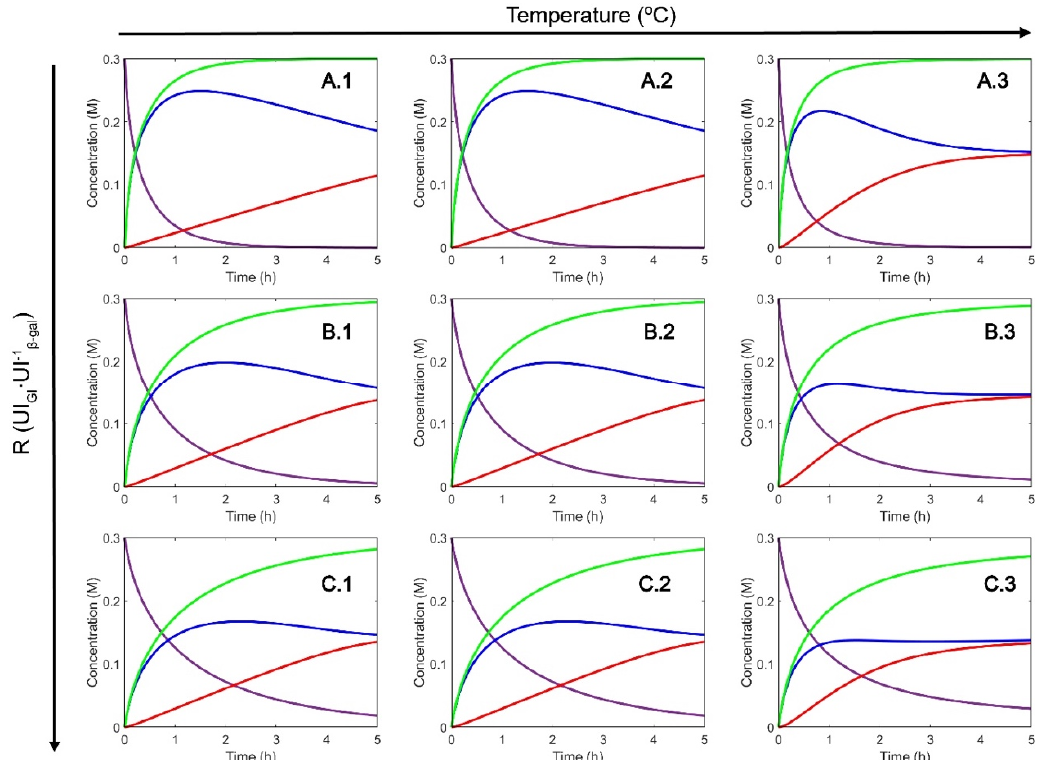
Figure 2. Substrates and products concentrations profiles during the one-pot production of lactofructose syrup in batch at different temperatures and GI/ β -gal activity ratio. (Temperatures: (1): 40 °C, (2): 45 °C and (3): 50 °C. GI/ β -gal activity ratio: ( A.1 – A.3 ): 0.1; ( B.1 – B.3 ): 0.3 and ( C.1 – C.3 ): 0.5. Purple: lactose; Green: galactose; Blue: glucose; Red: fructose).